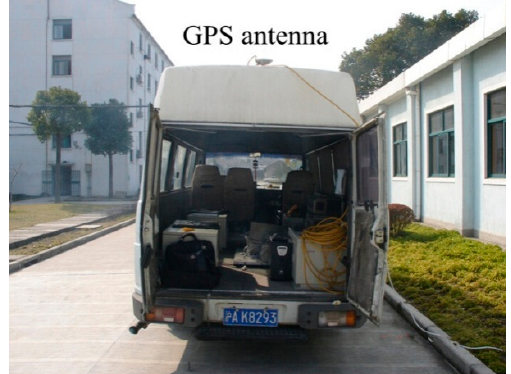
Figure 10. The experimental vehicle. Appl. Sci. 2017 , 7 , 759